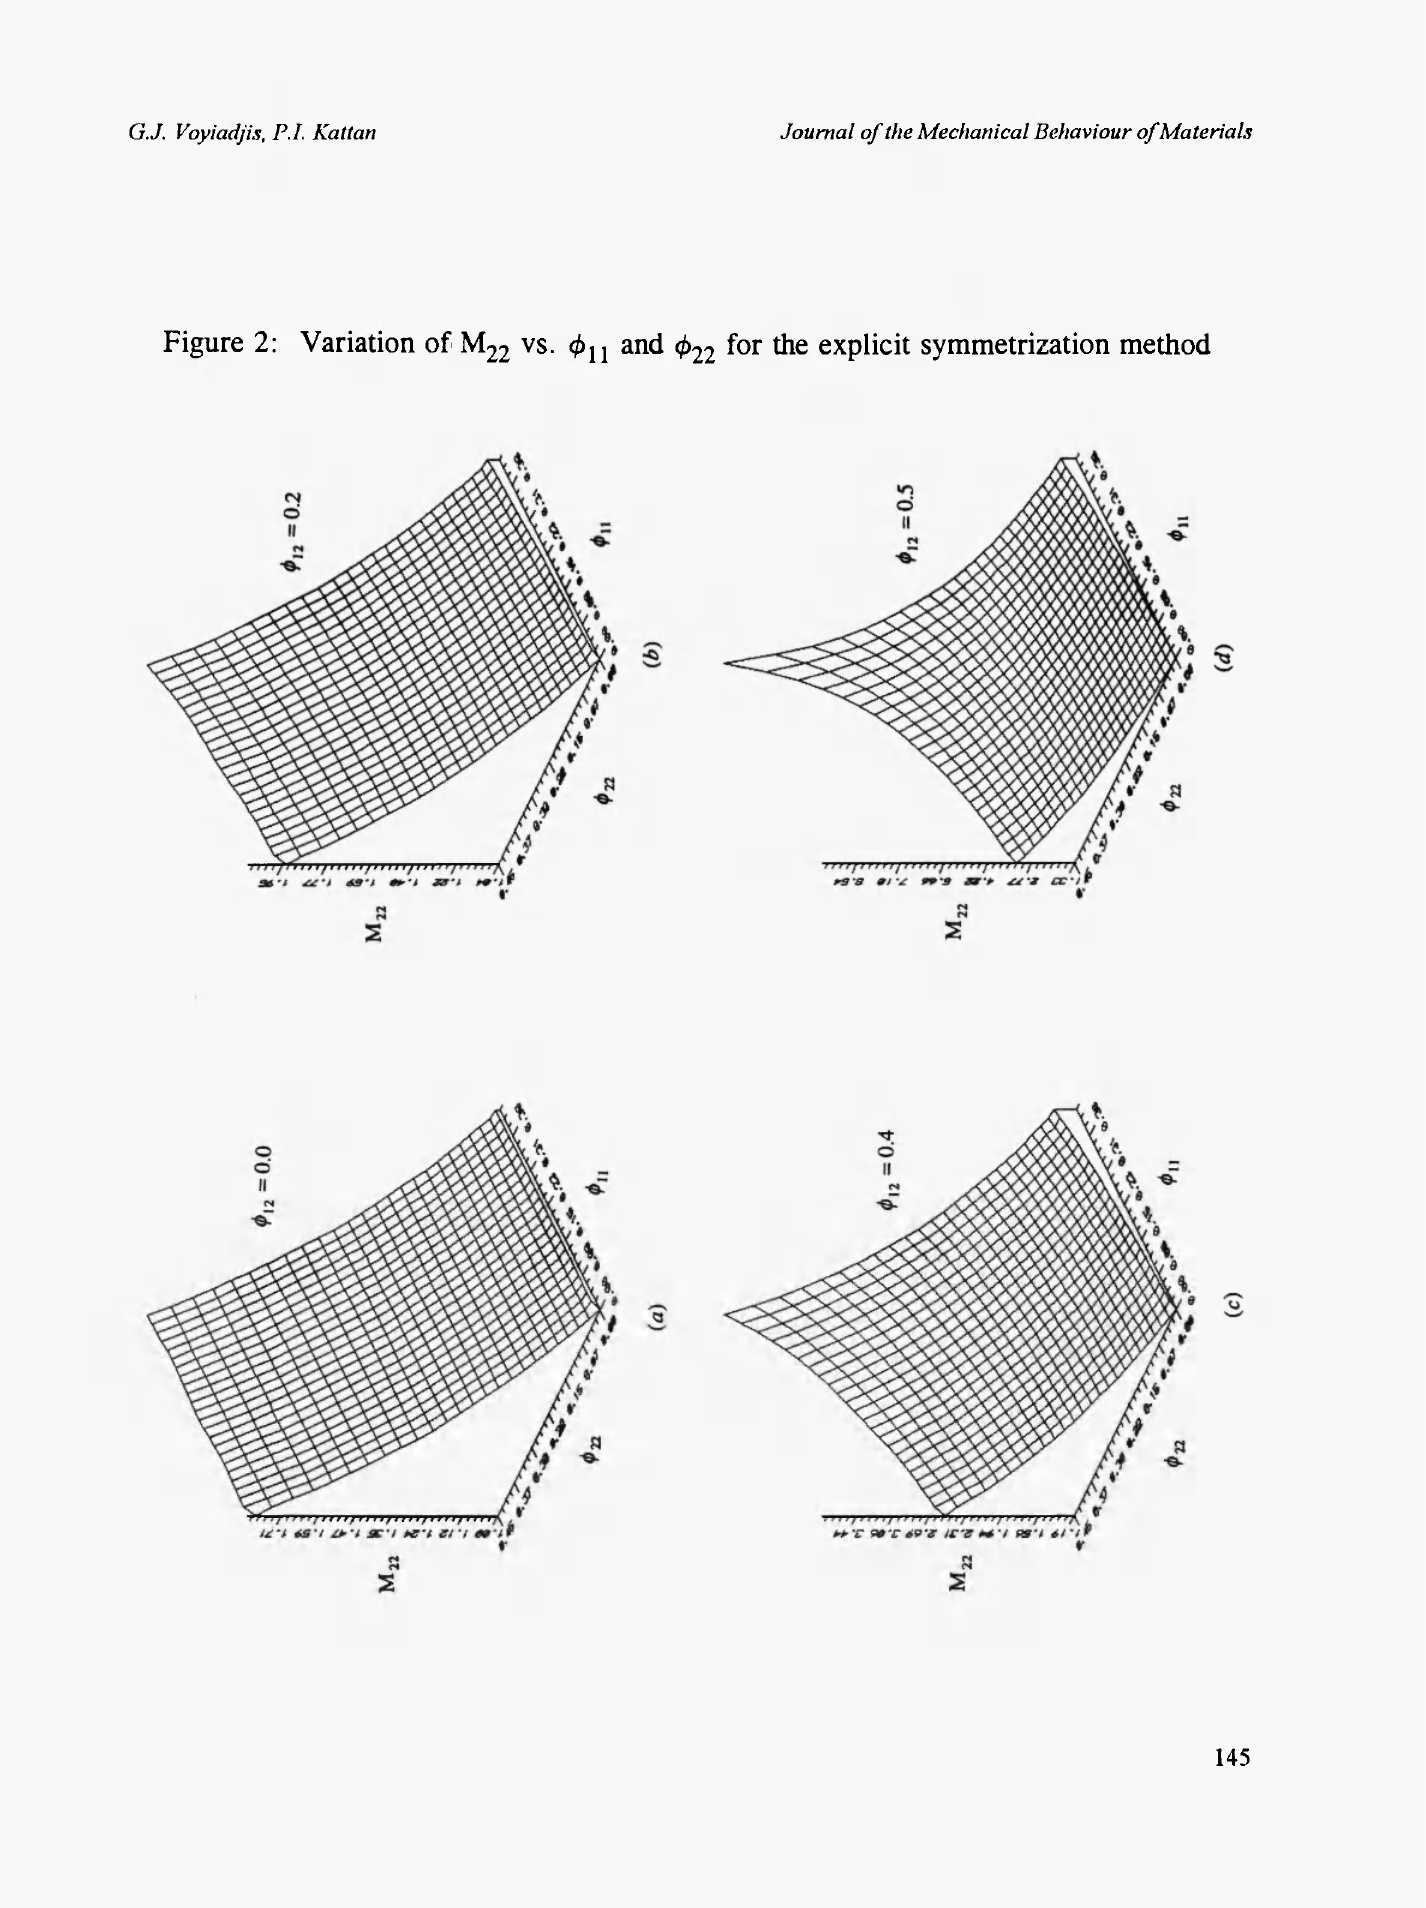
vs. φ and φ for the explicit symmetrization 22 ]Λ 22